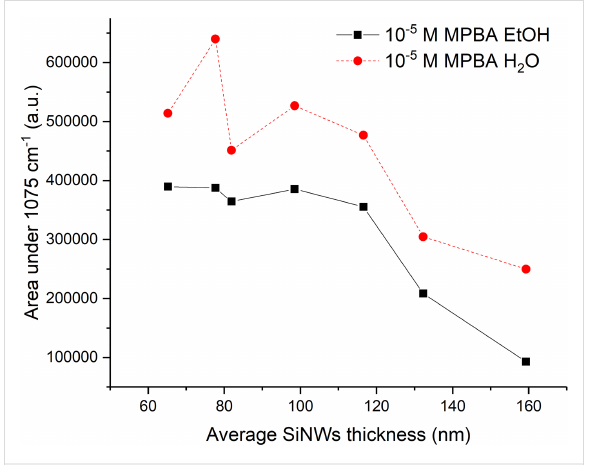
Figure 7: SERS enhancement after immersion in water.